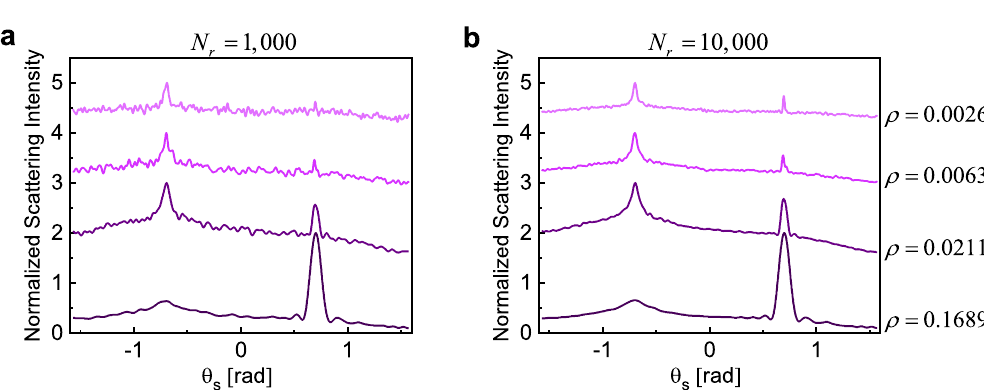
Figure 6. Normalized ensemble-averaged scattering intensity for random samples composed of N p = 10, 000 particles, where the size of the random media is increased from L = 10 (cid:31) 0 to L = 40 (cid:31) 0 in equal steps of 10 (cid:31) 0 (darker colors correspond to smaller boxes). Angle of incidence is fixed at θ i = 40 (deg) in all cases and the maximum of all curves is normalized to two. For clarity, each curved is moved one unit up compared to the previous one. The ensemble averaging is performed over ( a ) N r = 1, 000 and ( b ) N r = 10, 000 distinct